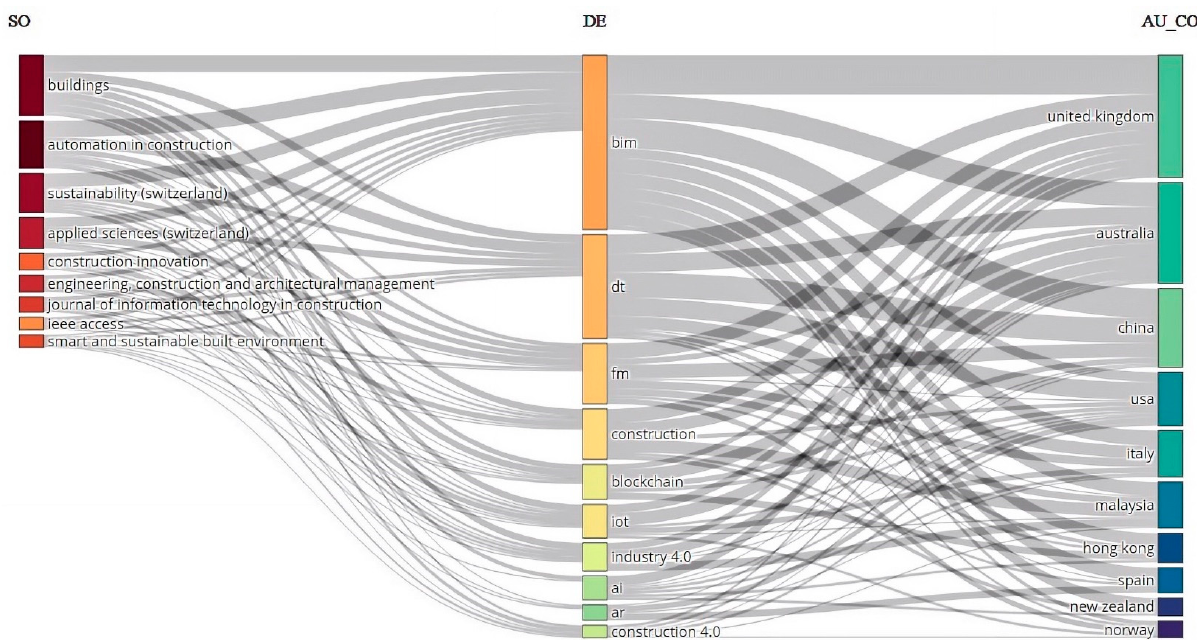
Figure 2. Three-field plot with, starting from the left side, sources, keywords and countries, performed with Biblioshiny version 4.0.